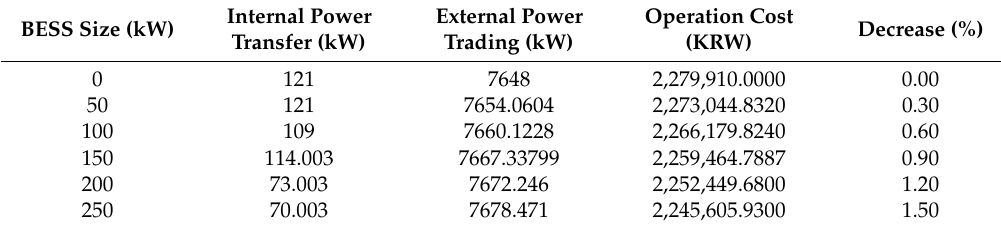
Table 6. Effect of BESS size on power transfer and operation